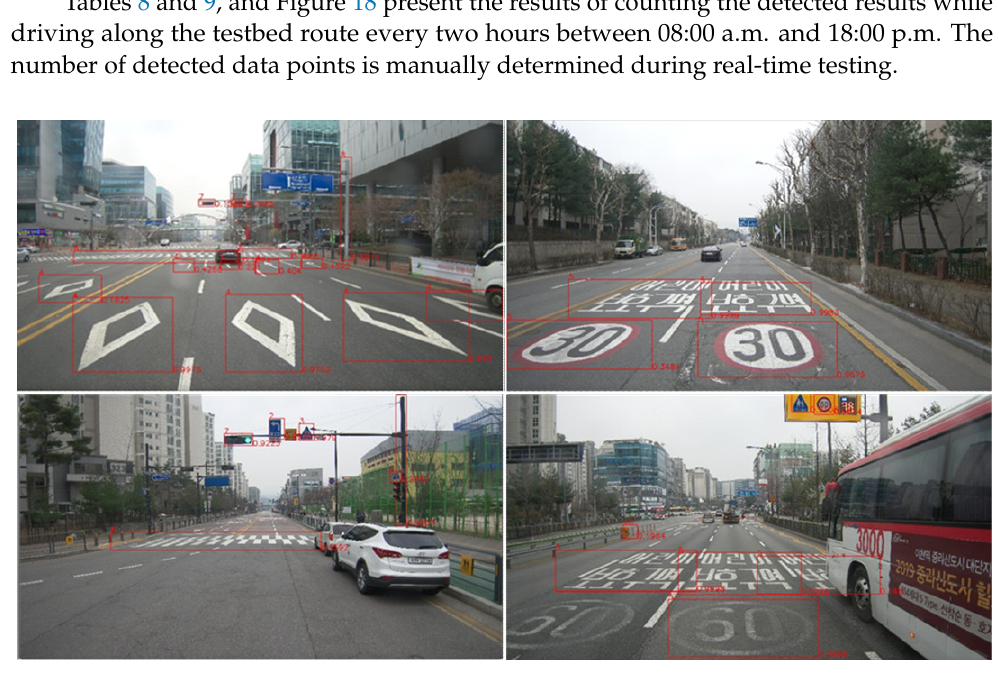
Figure 18. Experiment results of detecting traffic signs, road signs, and traffic lights in RMDS.